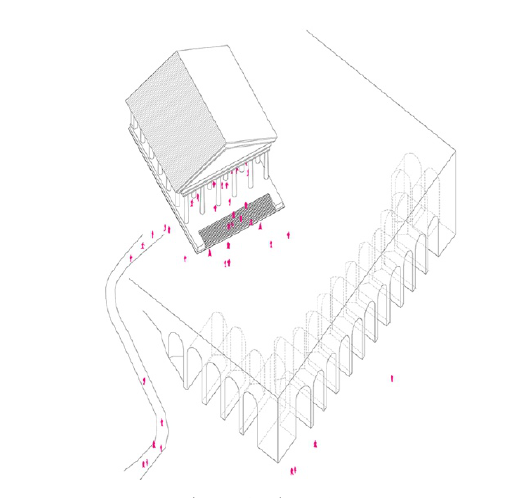
Figure 2. Emergency action for the safety of the main cloister after the earthquakes of August 2016